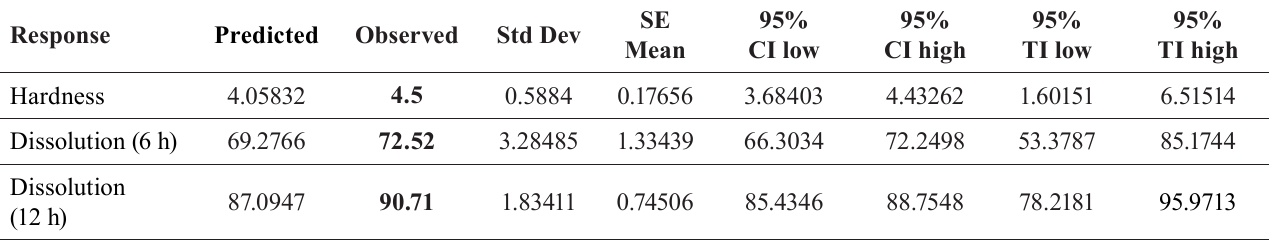
TABLE VII - Measured responses observed of optimized formula as per obtained by oveylay plot